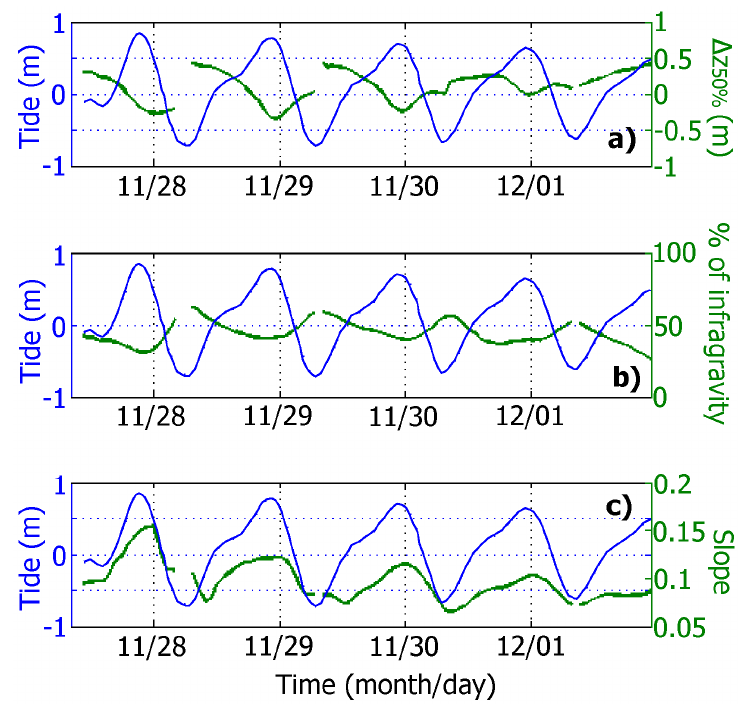
Figure 11. Cumulative vertical changes observed in the mid swash-zone ( ∆ z50% ) during the first four tidal cycles ( a ); percentage of infragravity on the vertical run-up observations ( b ); and slope changes ( c ).